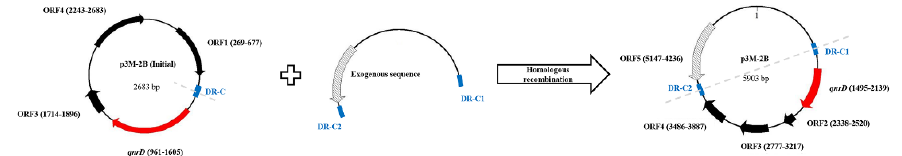
Figure 7. Possible model for in vivo formation of 5903-bp p3M-2B.